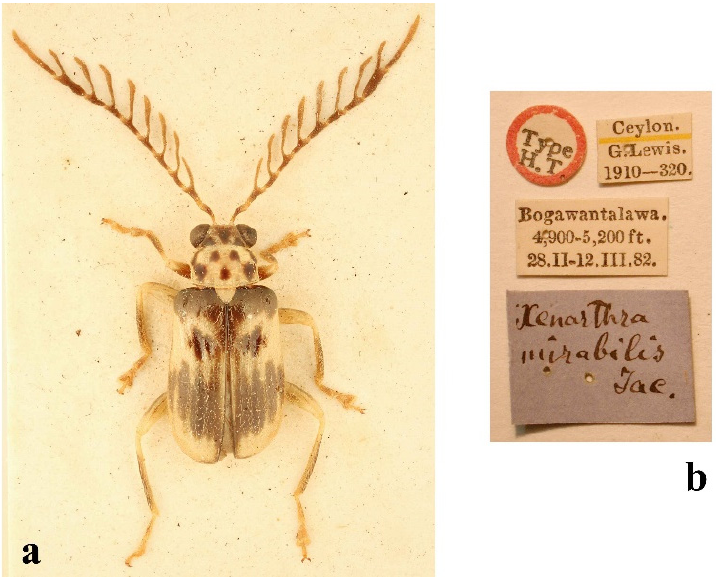
Type examined. Holotype: ♂ (BMNH, Figure 7a,b), “Type/H. T. [white round label with red frame, p]//Ceylon./G. Lewis./1910–320. [w, p]//Bogawantalawa./4900–5200 ft./28.II–12.III.82. [w, p]//Xenarthra / mirabilis/Jac. [b, h]’ (BMNH)”.